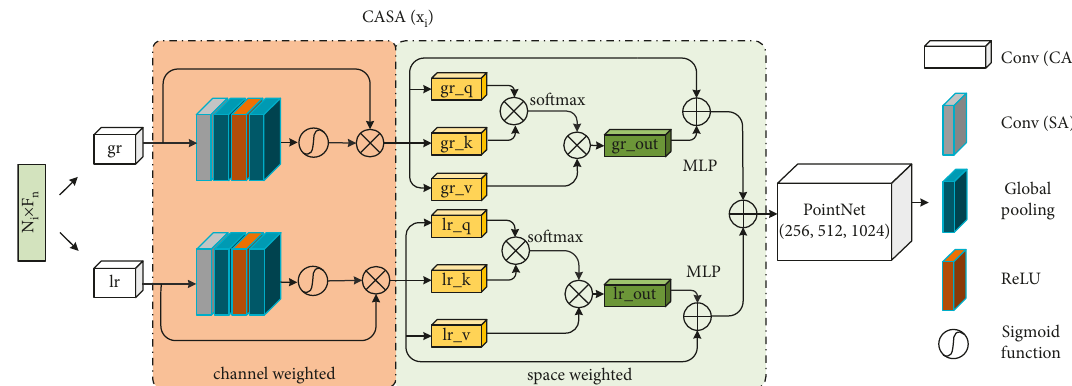
Figure 3: CASA module. gr and lr , respectively, represent the geometric and positional features of the sub-cloud. x feature of our CASA